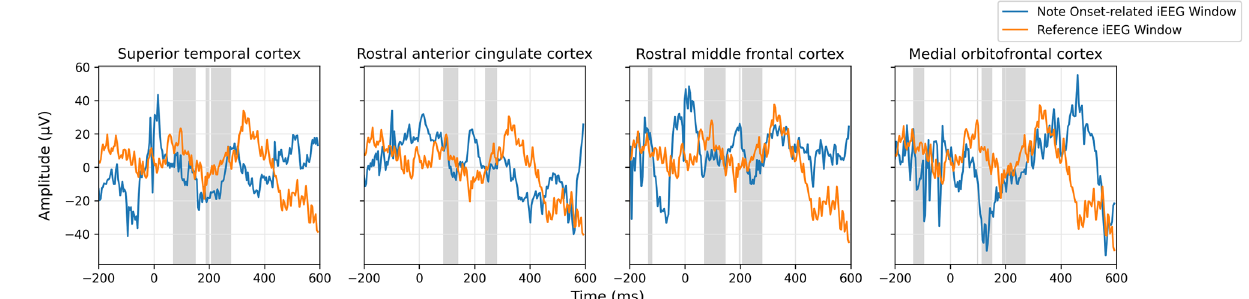
Figure 1. Note-Onset-related ERPs observed at these subregions with significance in at least six sessions are shaded in light gray.